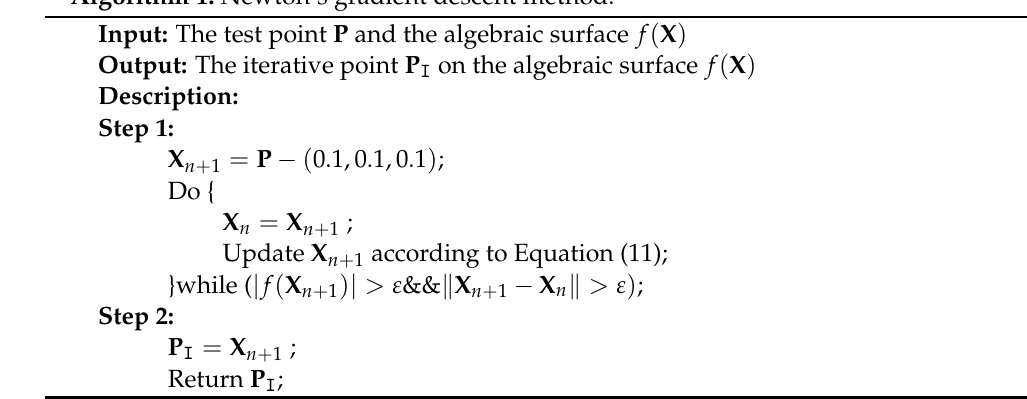
Algorithm 1: Newton’s gradient descent